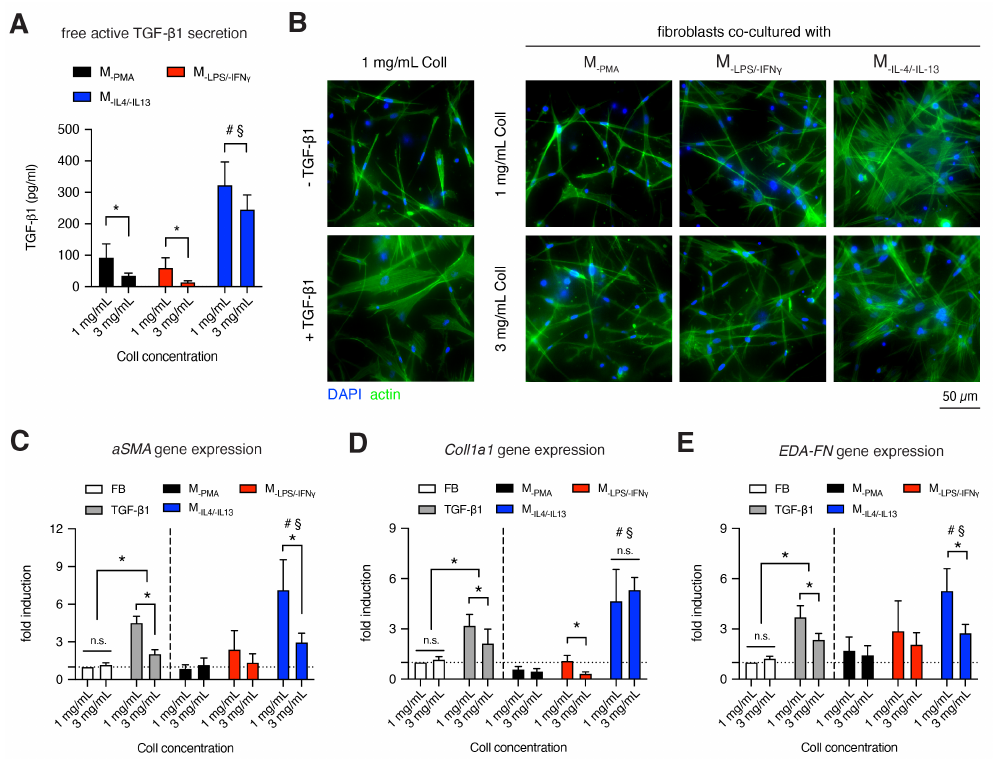
Figure 5. Fibroblast to myofibroblast differentiation in the presence of macrophages. (A) Quantitative analysis of active free TGF-β1 secretion by macrophages in a monoculture condition after 3 days of culture using ELISA (n = 6). Human dermal fibroblasts were cultured in a monoculture in the absence/presence of TGF-β1 (white and grey filled bar graphs), or co-culture with macrophages for 3 days (color filled bar graphs). (B) Representative images of fibroblasts in monoculture (left column) and co-cultured with macrophages. Cells were stained with Hoechst-33421 and phalloidin conjugated with Alexa Fluor 488 to visualize cell nuclei and f-actin, respectively. Gene expression of (C) alpha smooth muscle actin (aSMA), (D) Collagen 1 alpha 1 (Coll1a1) and (E) fibronectin containing extra domain A (EDA-FN) was analyzed. (n = 4). Fold induction was normalized to fibroblast without TGF-β1 treatment in monoculture. Data are represented as mean ± SD; * significance level of p < 0.05. The characters #, §, % represent the significance level of p < 0.05 when compared to M PMA , M LPS/IFNγ , and M IL-4/IL-13 macrophages, respectively.